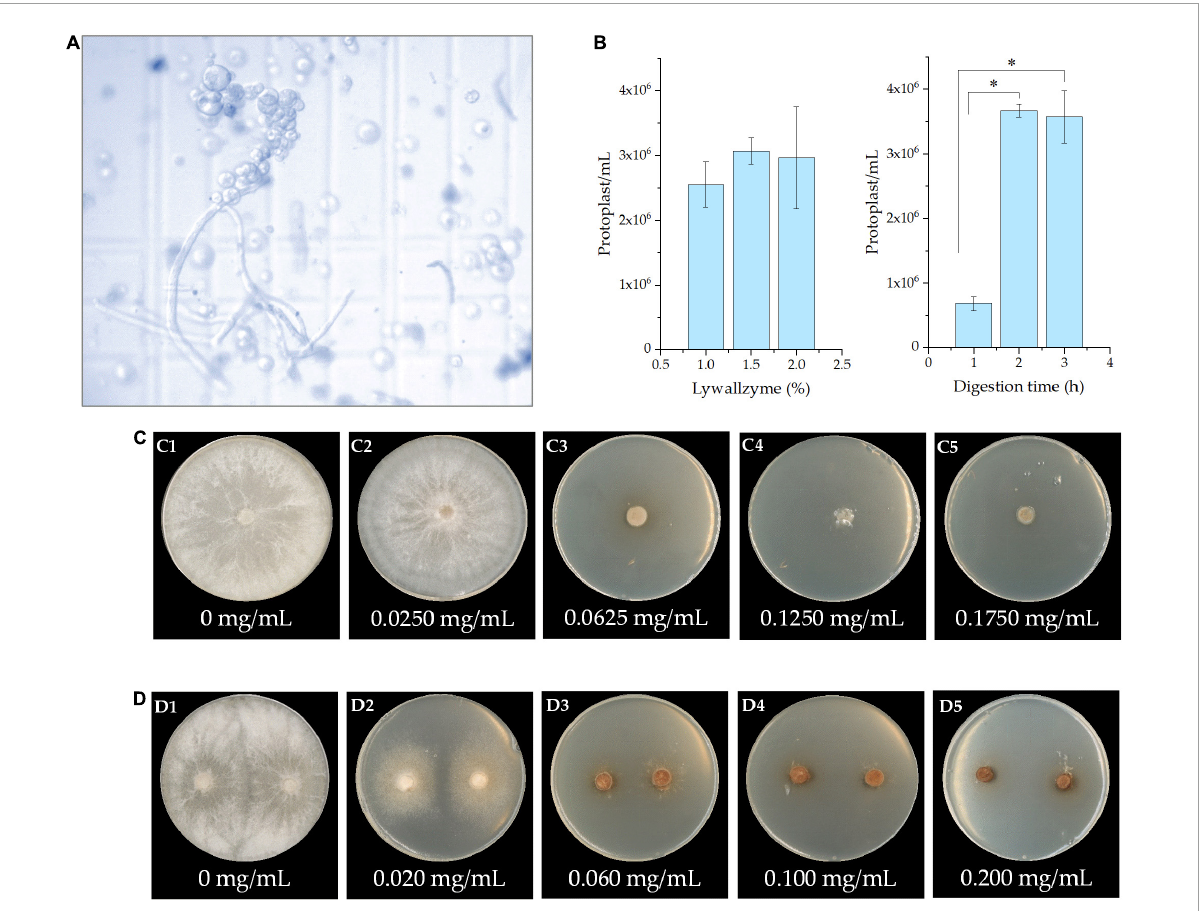
FIGURE3 The protoplast and identification of resistance marker of Poria cocos . (A) The microscopic observation of protoplasts obtained from the mycelia by lywallzyme digestion; (B) the optimization of concentration of lywallzyme and digestion time for protoplasts preparation; (C) the resistance marker selection of hygromycin; and (D) the resistance marker selection of 5-FOA at different concentration; ∗ P <